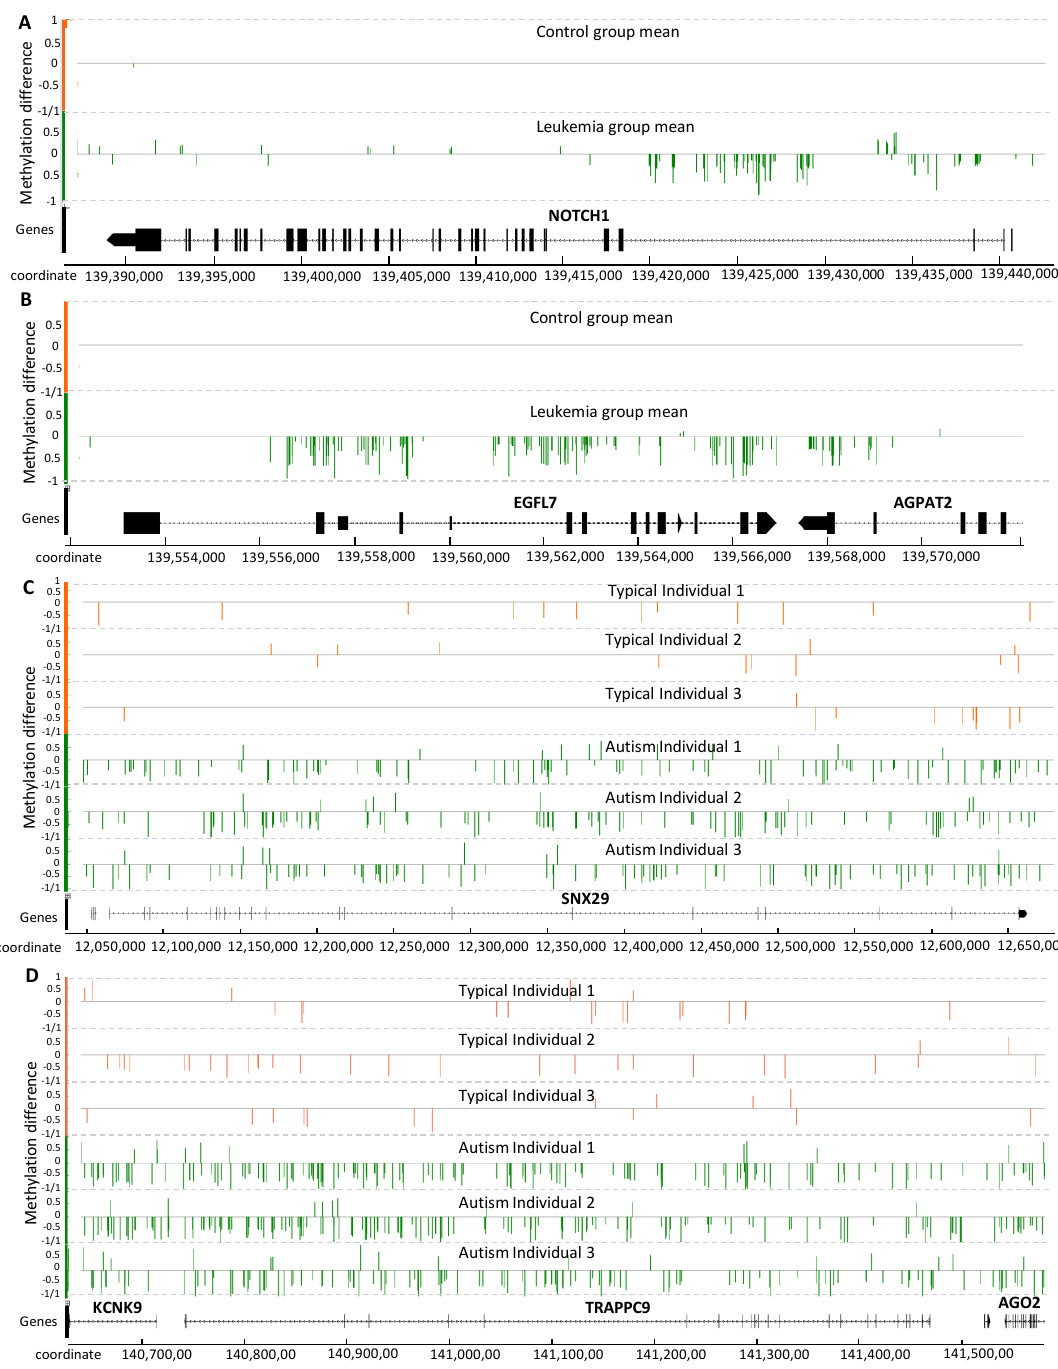
Figure 5. Distribution of the methylation signal on gene-body for seven relevant genes reported to be associated with PALL ( A , B ) and autism ( C , D ). Methylation level difference at each cytosine is computed by ( mC /( mC + uC )) each individual − ( mC /( mC + uC ) average of all reference individuals , with mC and uC denoting the numbers of methylated and unmethylated reads, respectively. Each cytosine is represented by one single vertical line. The Integrated Genome Browser (version 9.0.2) was used to generate this figure.